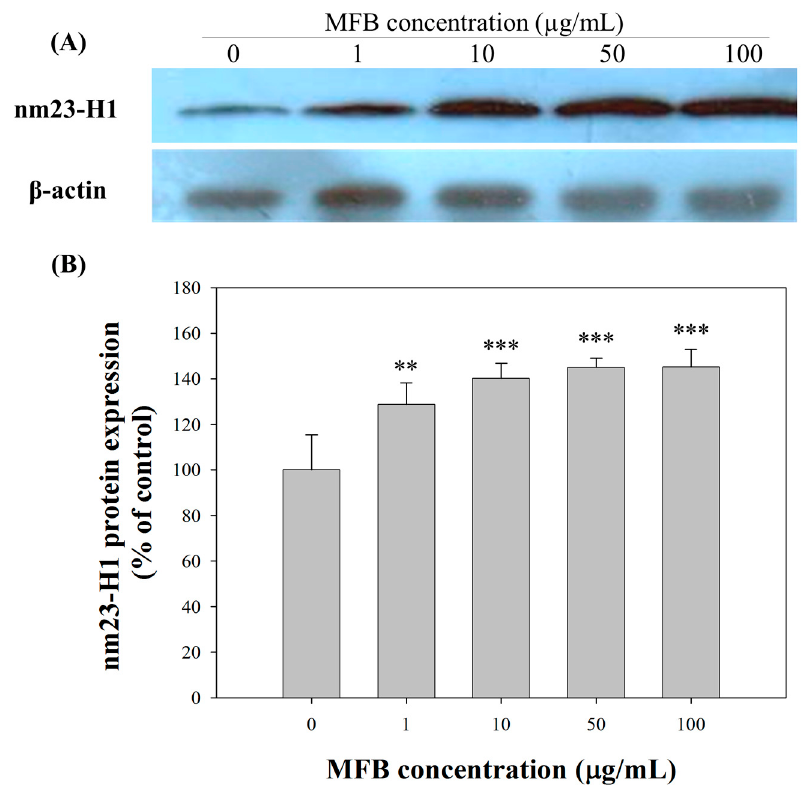
Figure 5. Effects of MFB on nm23-H1 protein expression in SK-Hep-1 cells. Cells were incubated with MFB at various concentrations (1–100 µg/mL) for 24 h. ( A ) Western blots of nm23-H1and β -actin; ( B ) Densitometric analysis of ( A ). For the loading control, expression levels of β -actin were analyzed by using the same lysate. Values are means ± SD, n = 3; significant difference from control value was indicated ** p < 0.01, and *** p < 0.001.